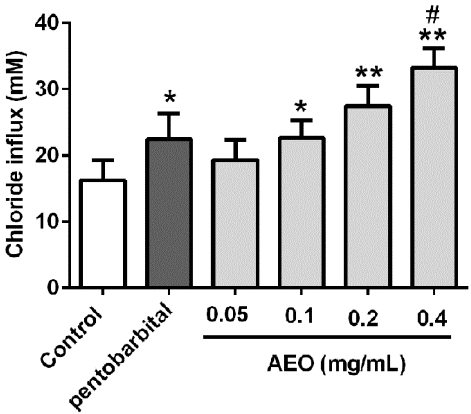
Figure 9. Effects of AEO on chlorine ion (Cl − ) influx in SH-SY5Y cells. The results are presented as mean ± SEM with n = 8. * p < 0.05 and ** p < 0.01 vs. control group. # p < 0.05 vs. pentobarbital group.